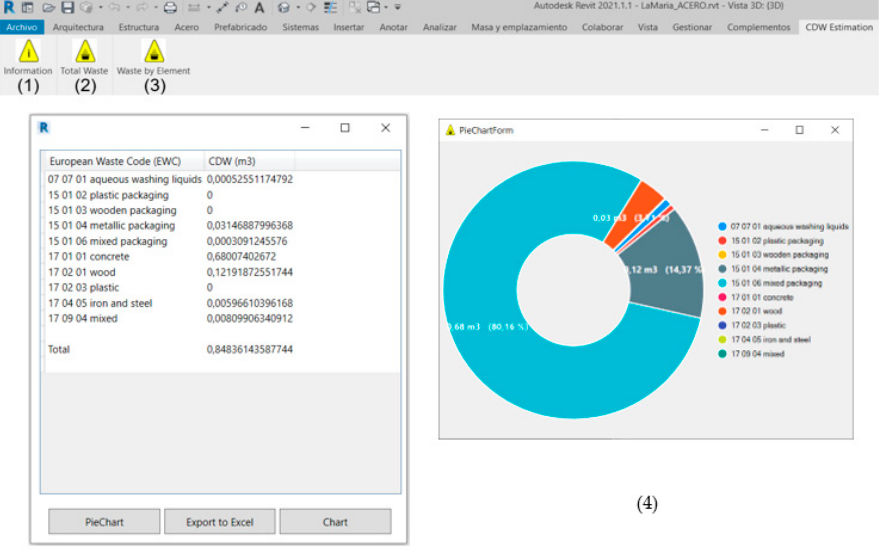
Figure 3. Interface: (1) tab for Add-in information; (2) tab for waste estimation per building; (3) tab for waste estimation per element; (4) data display for waste estimation per element; (4) data display windows.